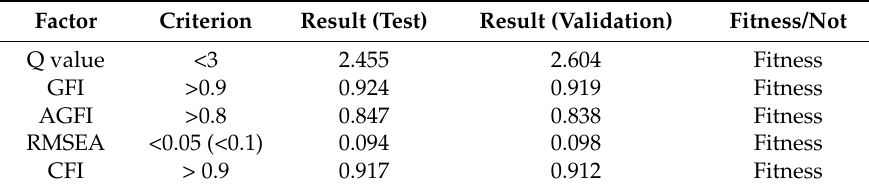
Table 6. Fitness of structural equation model for effluent